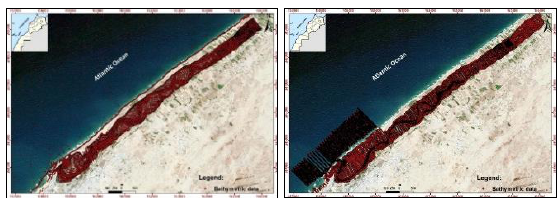
Figure 2. Bathymetric survey in Oualidia lagoon, left (2006), right